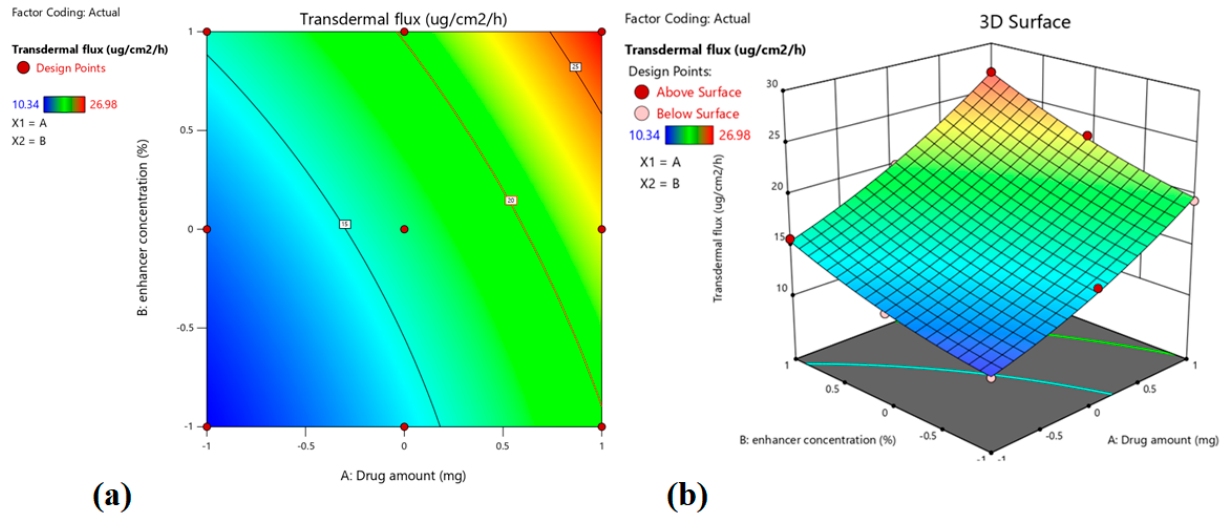
Figure 4. Contour plot ( a ) and 3D surface plot ( b ) showing the effect of drug amount and enhancer concentration on transdermal flux.